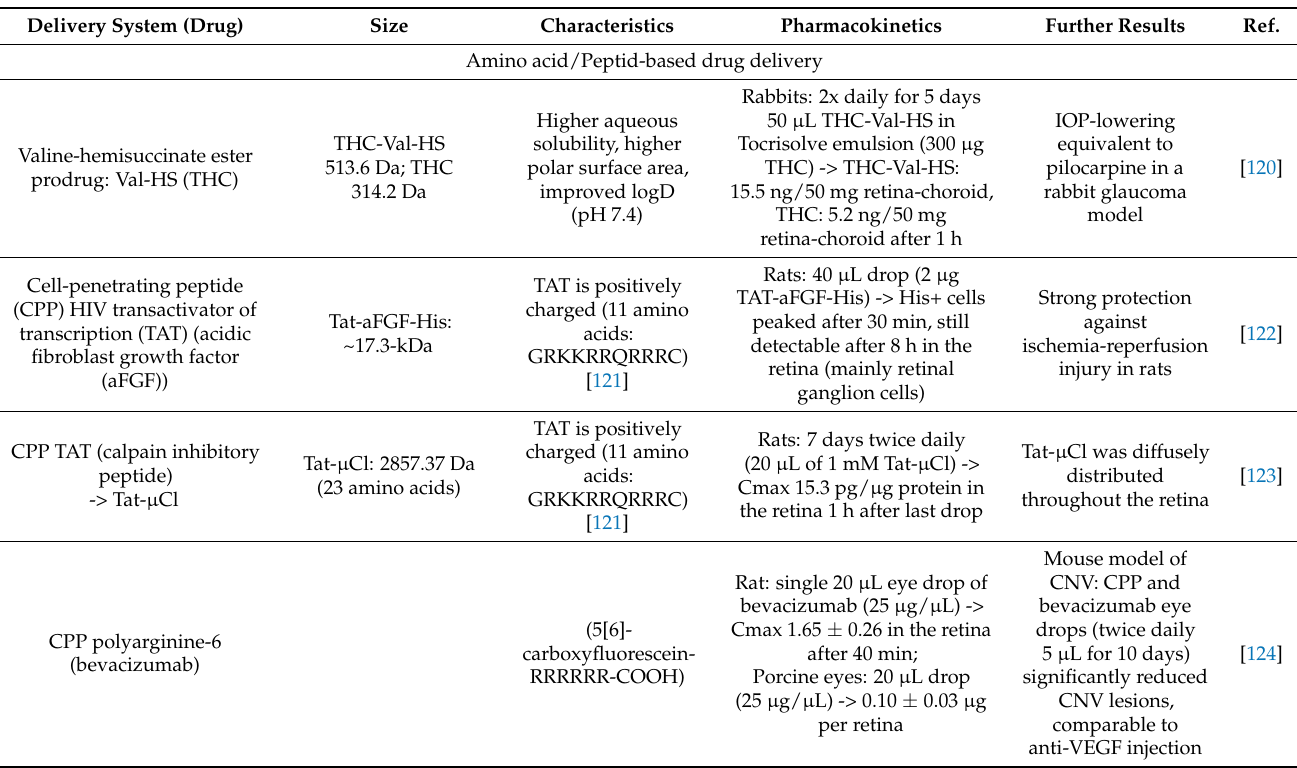
Table 4. Overview on drug delivery systems for topical delivery to the posterior